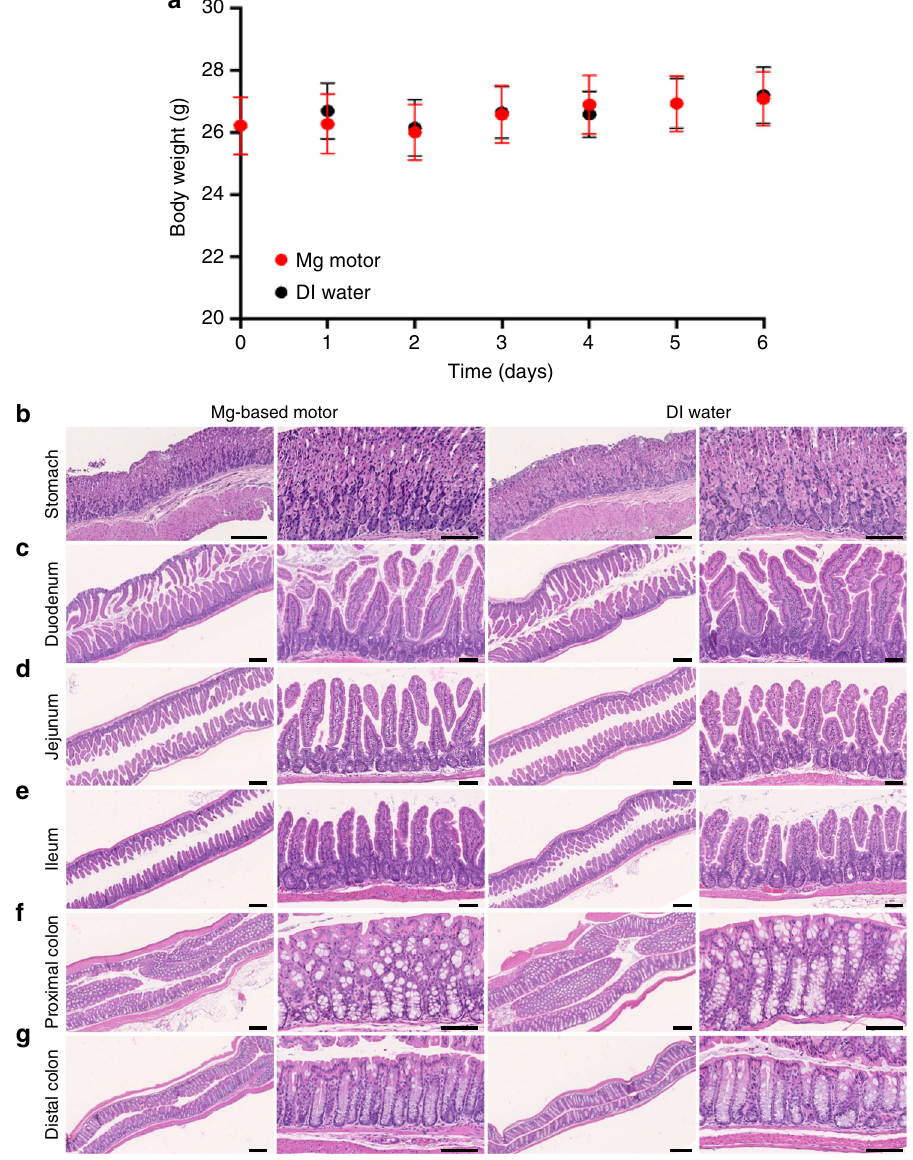
Fig. 5 In vivo toxicity evaluation of the Mg-based micromotors. Uninfected mice were orally administered with the Mg-based micromotors or DI water once daily for fi ve consecutive days. a Mouse body weight log from day 0 to day 6 of the toxicity study. Error bars represent the s.d. of the mean ( n = 6). On day 6, mice were killed and sections of the mouse stomach b , small c – e and large f , g intestine tissues were processed for histological staining with hematoxylin and eosin ( H&E ). Scale bars Mg-motor, 250 and 100 μ m ( left and right column , respectively); DI water, 250 and 100 μ m ( left and right column ,